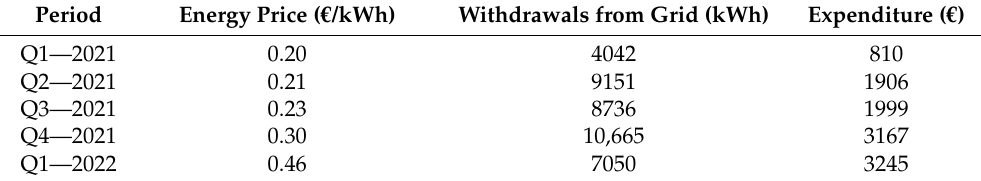
Table 9. Revenue and expenditure.